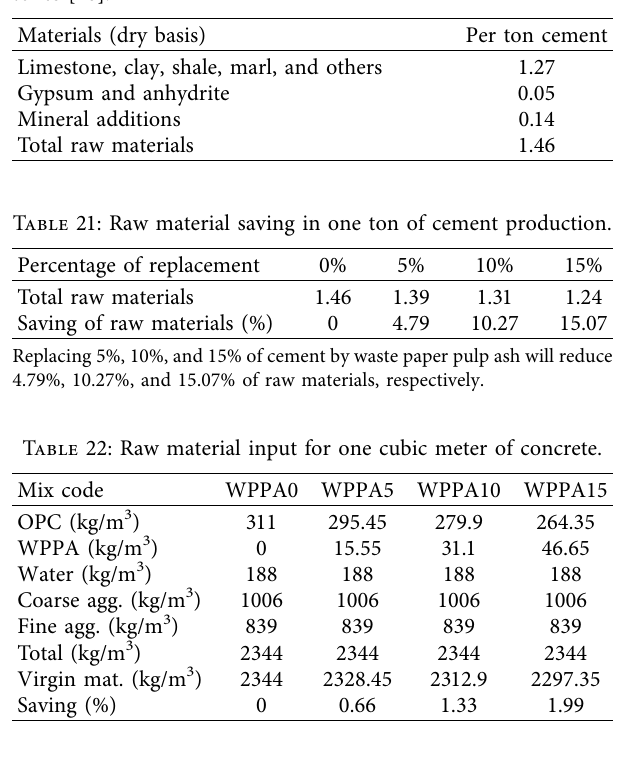
Figure 3: Waste paper dumped in the environment from offices and incinerated. Table 20: Consumption of raw materials in cement production in tones [20].